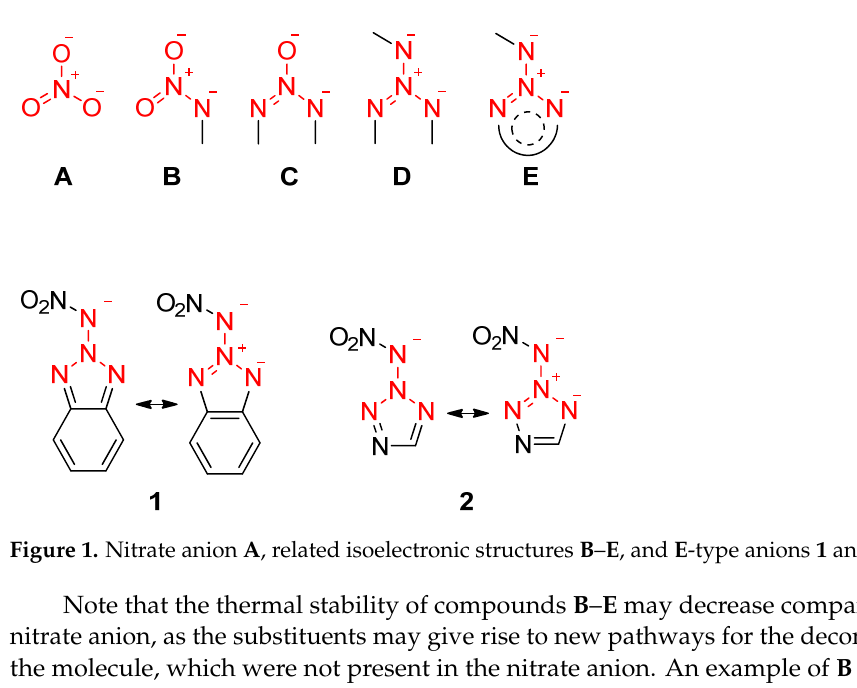
Figure 1. Nitrate anion A , related isoelectronic structures B – E , and E -type anions 1 and 2 .